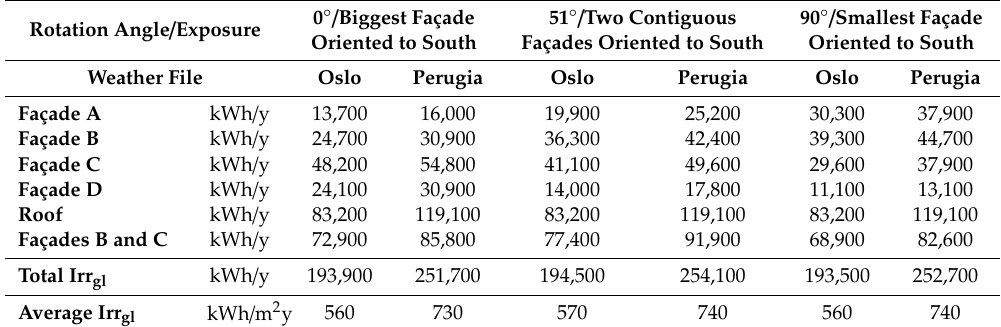
Table 8. Optimization performed by the Galapagos evolutionary solver on solar analyses in Step 2 . Rotation Angle /